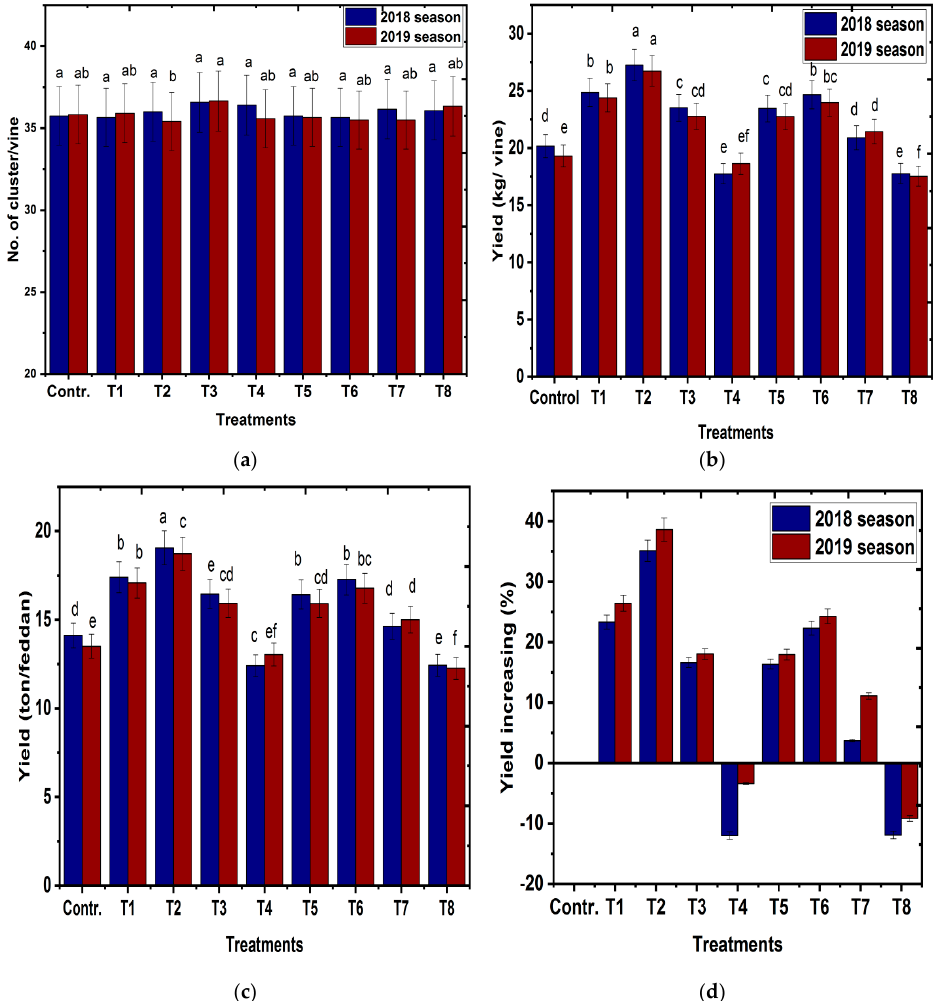
Figure 3. Effect of hand thinning and GA 3 spray sizing on ( a ) the number of clusters/vine, ( b ) yield (kg)/vine, ( c ) yield (ton)/feddan and ( d ) relative yield change compared to control (%) of Sultanina grapevines (H4 strain) in 2018 and 2019 seasons. Control: without removing any shoulders of the cluster, T1:25% hand thinning + 20 ppm GA3 sizing, T2:25% hand thinning + 30 ppm GA3 sizing, T3:25% hand thinning + 40 ppm GA3 sizing, T4:25% hand thinning without GA3 sizing, T5:50% hand thinning + 20 ppm GA3 sizing, T6:50% hand thinning + 30 ppm GA3 sizing, T7:50% hand thinning + 40 ppm GA3 sizing and T8:50% hand thinning without GA3 sizing. Means in each column followed by the same letter (s) are not significantly different at ( p ≤ 0.05), using Duncan’s Multiple Range Test.